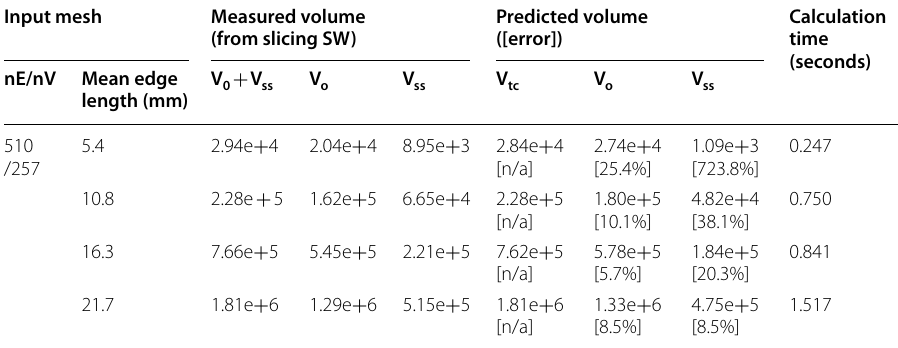
“†Measured volume” were calculated from slicing SW’s total filament lengths